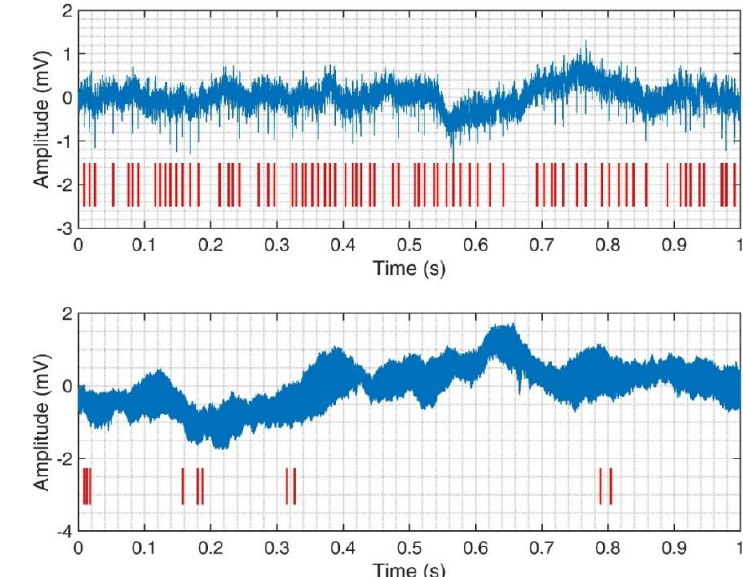
Figure 1. ( a ) A 1 s frame of synthetic data generated with NEUROCUBE toolbox. The spike train follows an exponential distribution with a firing rate of 100 Hz. This explains the higher number of spikes compared to the real data ( b ) where the firing rate on average is few Hz. The SNR for both the tracks is around 10 dB.